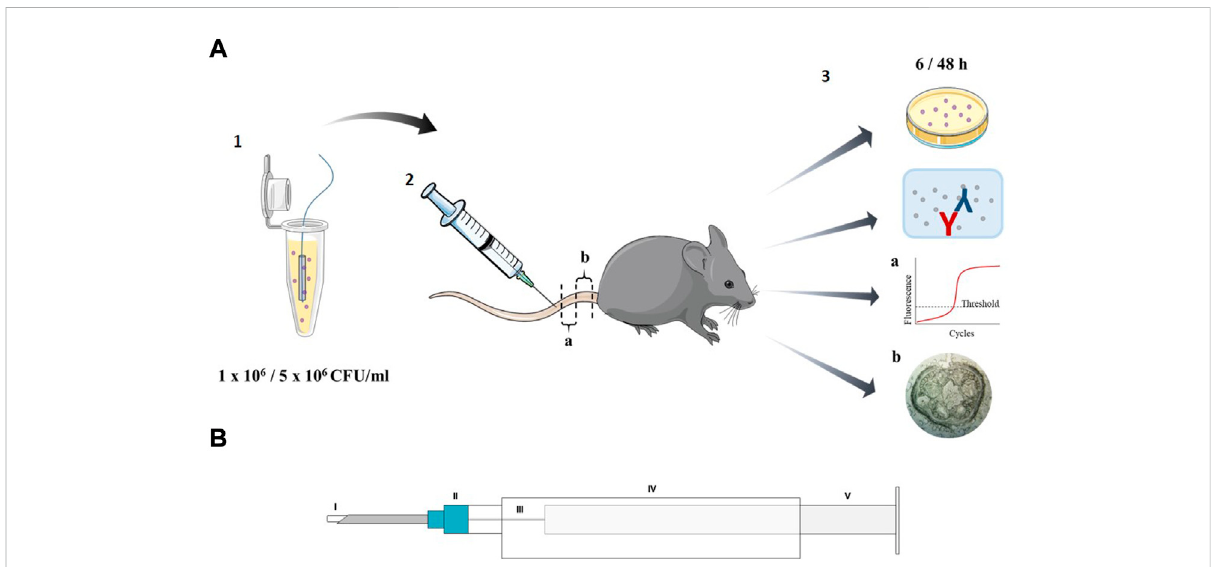
FIGURE 1 Schematicrepresentationof (A) theexperimentalset-upincluding(1)contaminationoftheimplantusingdippingprotocol(2)applicationofthe implantsintothetailveinofmiceand(3)analysisofthemicelocalandsystemicreaction;(a)partofthetailforqPCRanalysisand(b)histologyand (B) the insertion system containing (I) the implant (II) 21 1 / 2 G needle (III) guide wire, 0.4 mm diameter (IV) 5 ml syringe body (V) 1 ml syringe